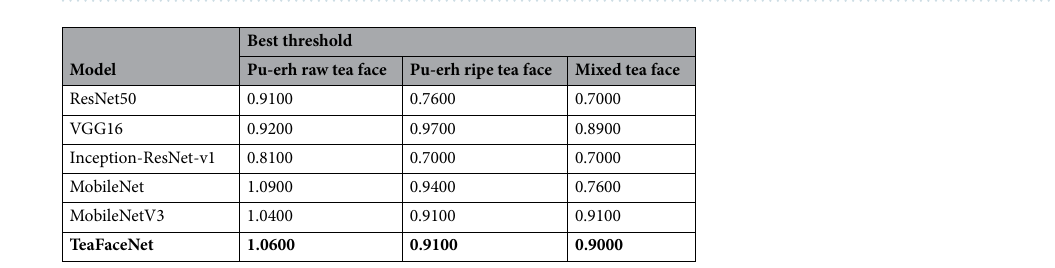
Table 7. Model optimal thresholds. Significant are in value